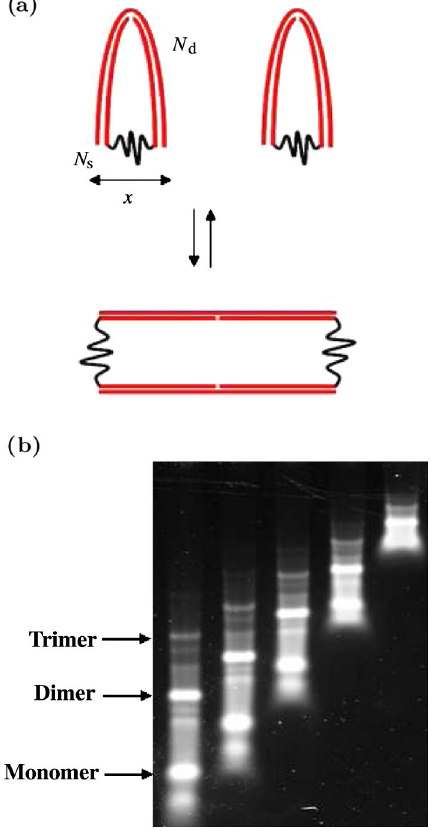
FIG. 2. (a) Sketch of the monomer-dimer equilibrium used to measure the elastic energy of the monomer in [20]. The mono- mer is stressed because the ds part of the molecule has to bend and the ss part has to stretch, but the stress is relaxed in the dimer. (b) Example of a gel used to determine the concentrations of monomers and dimers in the dimerization equilibrium experi- ments [20]. All lanes were loaded with the same sample, at successive (10 min) intervals. The purpose is to extrapolate back in time the initial (equilibrium) concentrations of the two species at ‘‘zero’’ time, since some monomer-dimer interconversion occurs in the gel. This interconversion produces the ‘‘smear’’ and extra bands visible mostly between the monomer and dimer bands; it is accounted for by the reaction-diffusion model we use to fit the intensity profiles and extrapolate the concentrations to zero time. This method is detailed in [19]. The band in front of the monomer band is ss DNA and arises because the stoichi- ometry of the two strands used for the monomer construction is not exactly 1:1 .